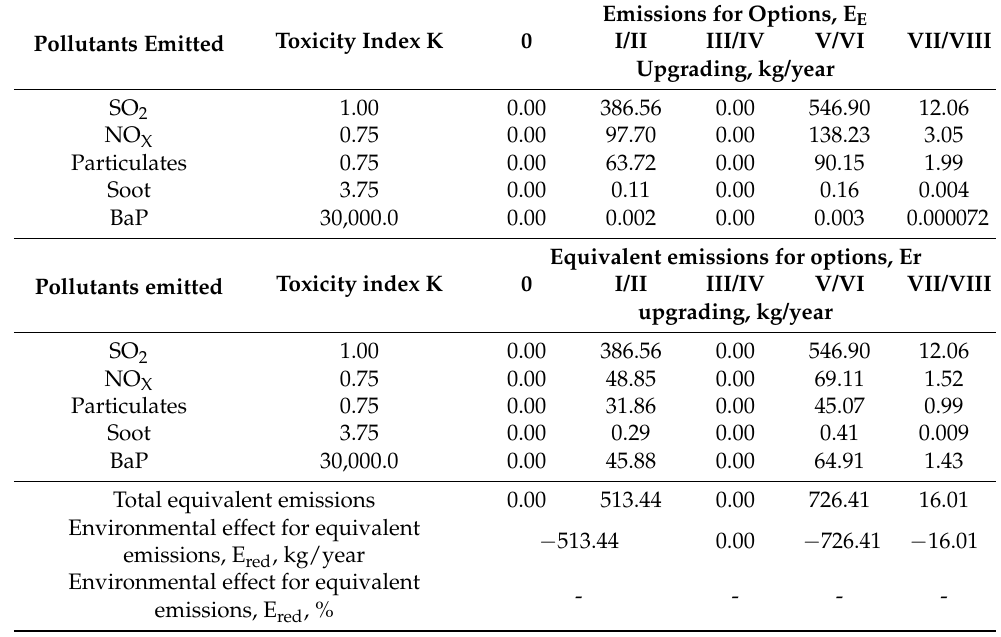
Table 4. Equivalent emissions for the optimal thermal-upgrading option in the building .